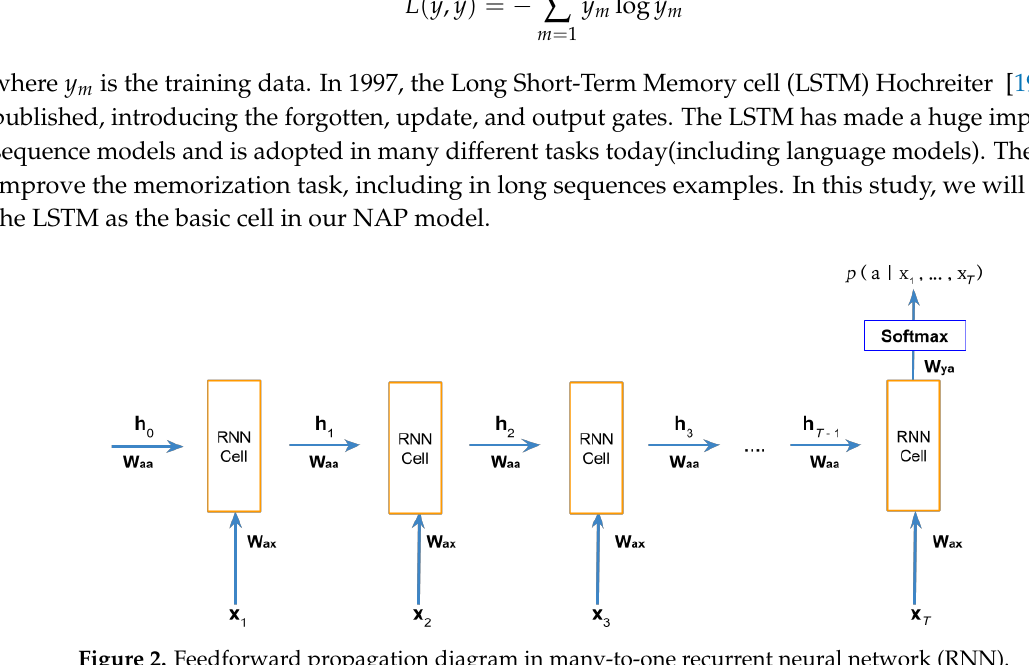
Figure 2. Feedforward propagation diagram in many-to-one recurrent neural network